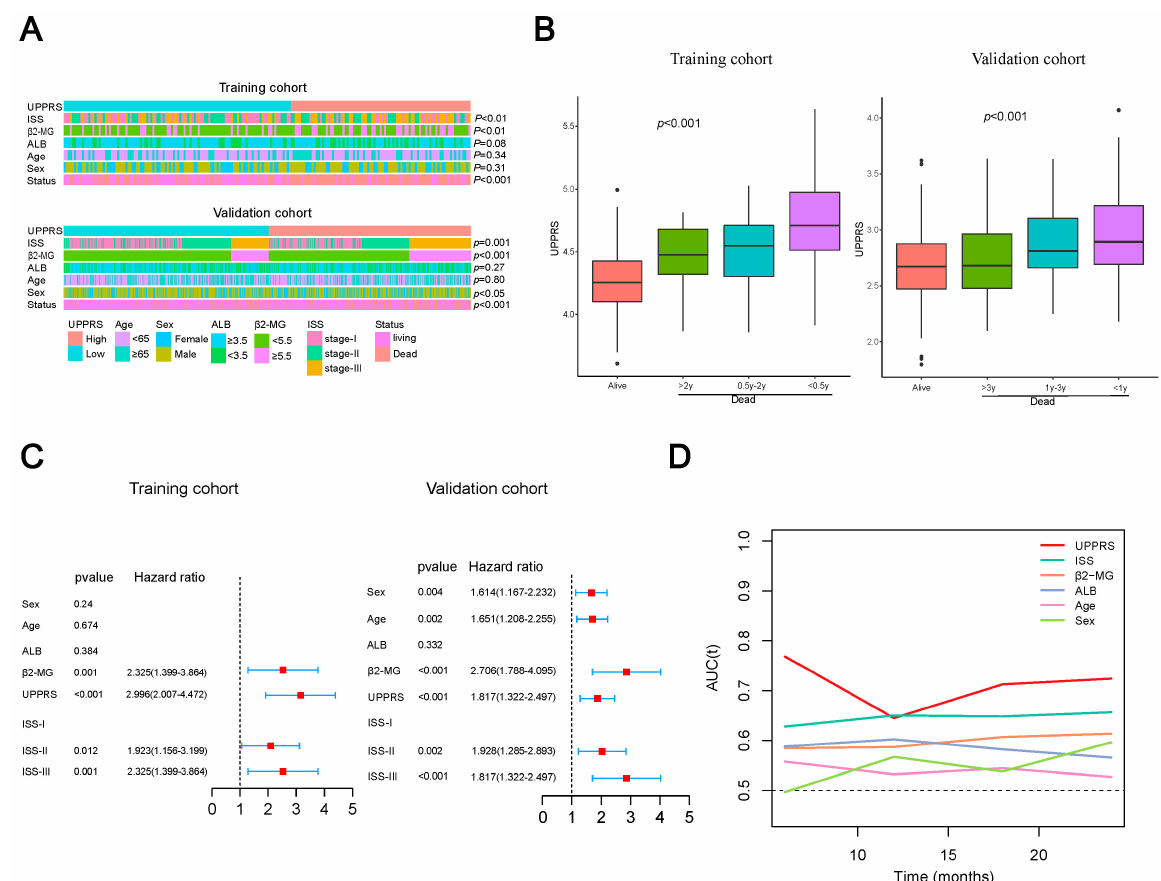
Figure 3. The clinical benefits of UPPRS. ( A ) A heatmap depicting the association between UPPRS and clinicopathological characteristics in two groups. ( B ) UPPRS were significantly elevated in deceased patients, especially in shorter survival groups. ( C ) Multivariate cox analysis of UPPRS combined some common clinical factors in both cohorts. ( D ) tROC analysis of UPPRS and other clinical variables in the prediction of MM patients in the training